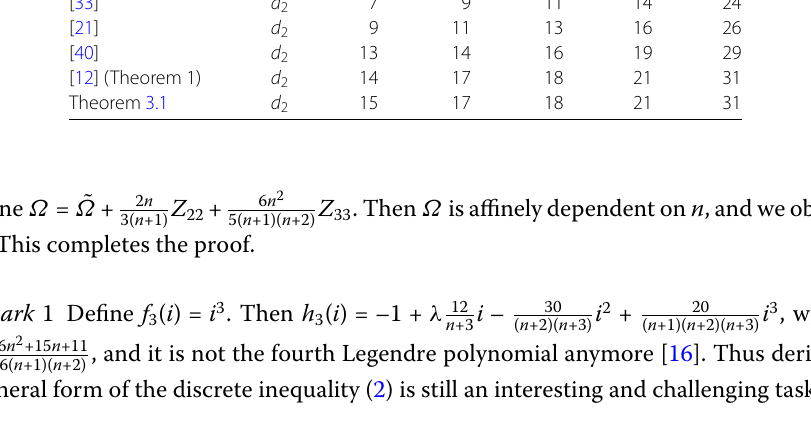
Table 2 Allowable delay upper bound d 2 for various d 1 for Example 2 Method d